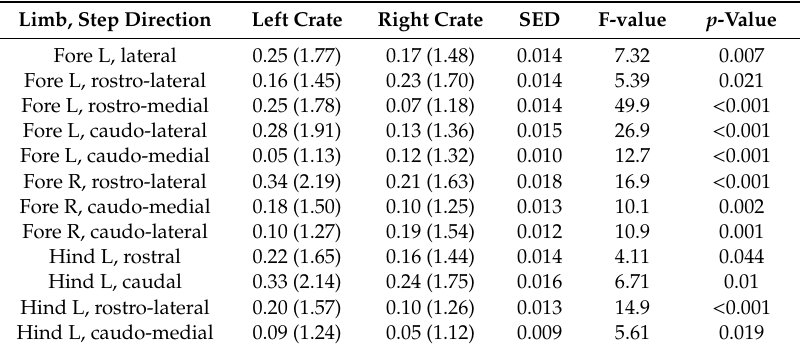
Table A6. E ff ects of side positioning of crated sheep on their stepping behavior in response to floor motion ( n = 6). Data presented as (log 10 + 1) steps / 20 min, with back-transformed means provided in brackets. Comparisons with significantly di ff erent counts of stepping responses are presented, with these data also presented graphically in Figure 6. (L = left and R =